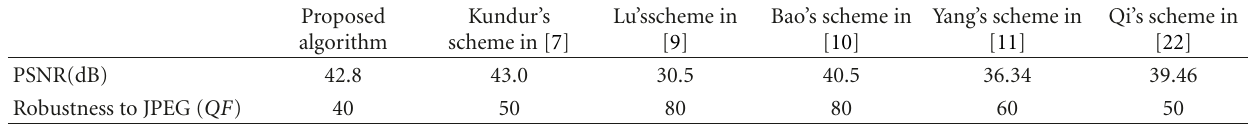
Table 8: Comparisons with other methods in [7, 9–11, 22] on image “Lena.”